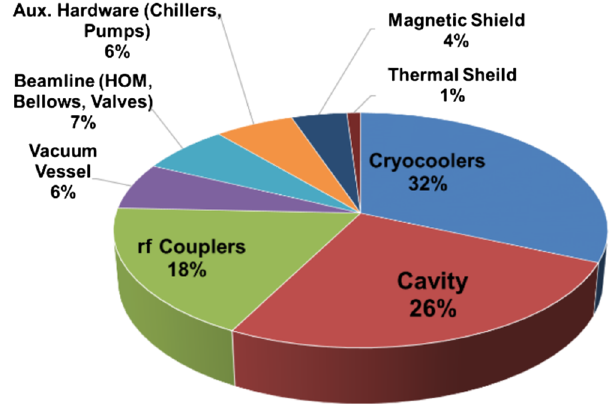
TABLE VIII. Capital cost of the 1 MW, 10 MeV SRF